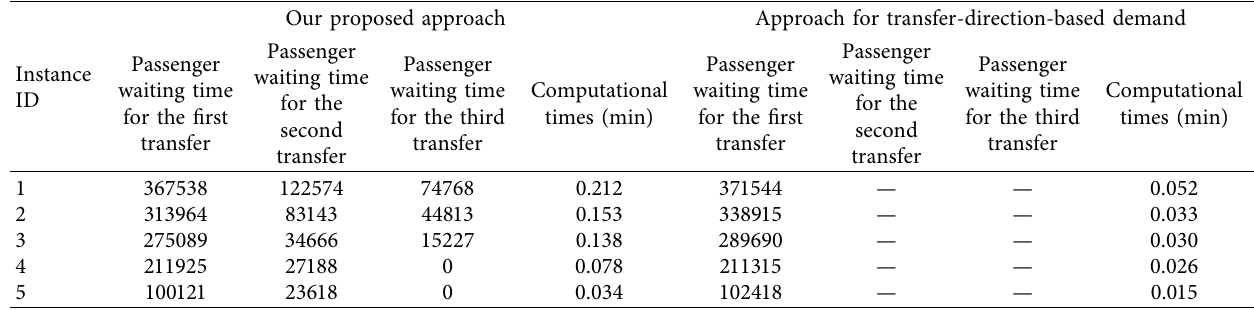
Table 11: Comparison of the two approaches with different demand